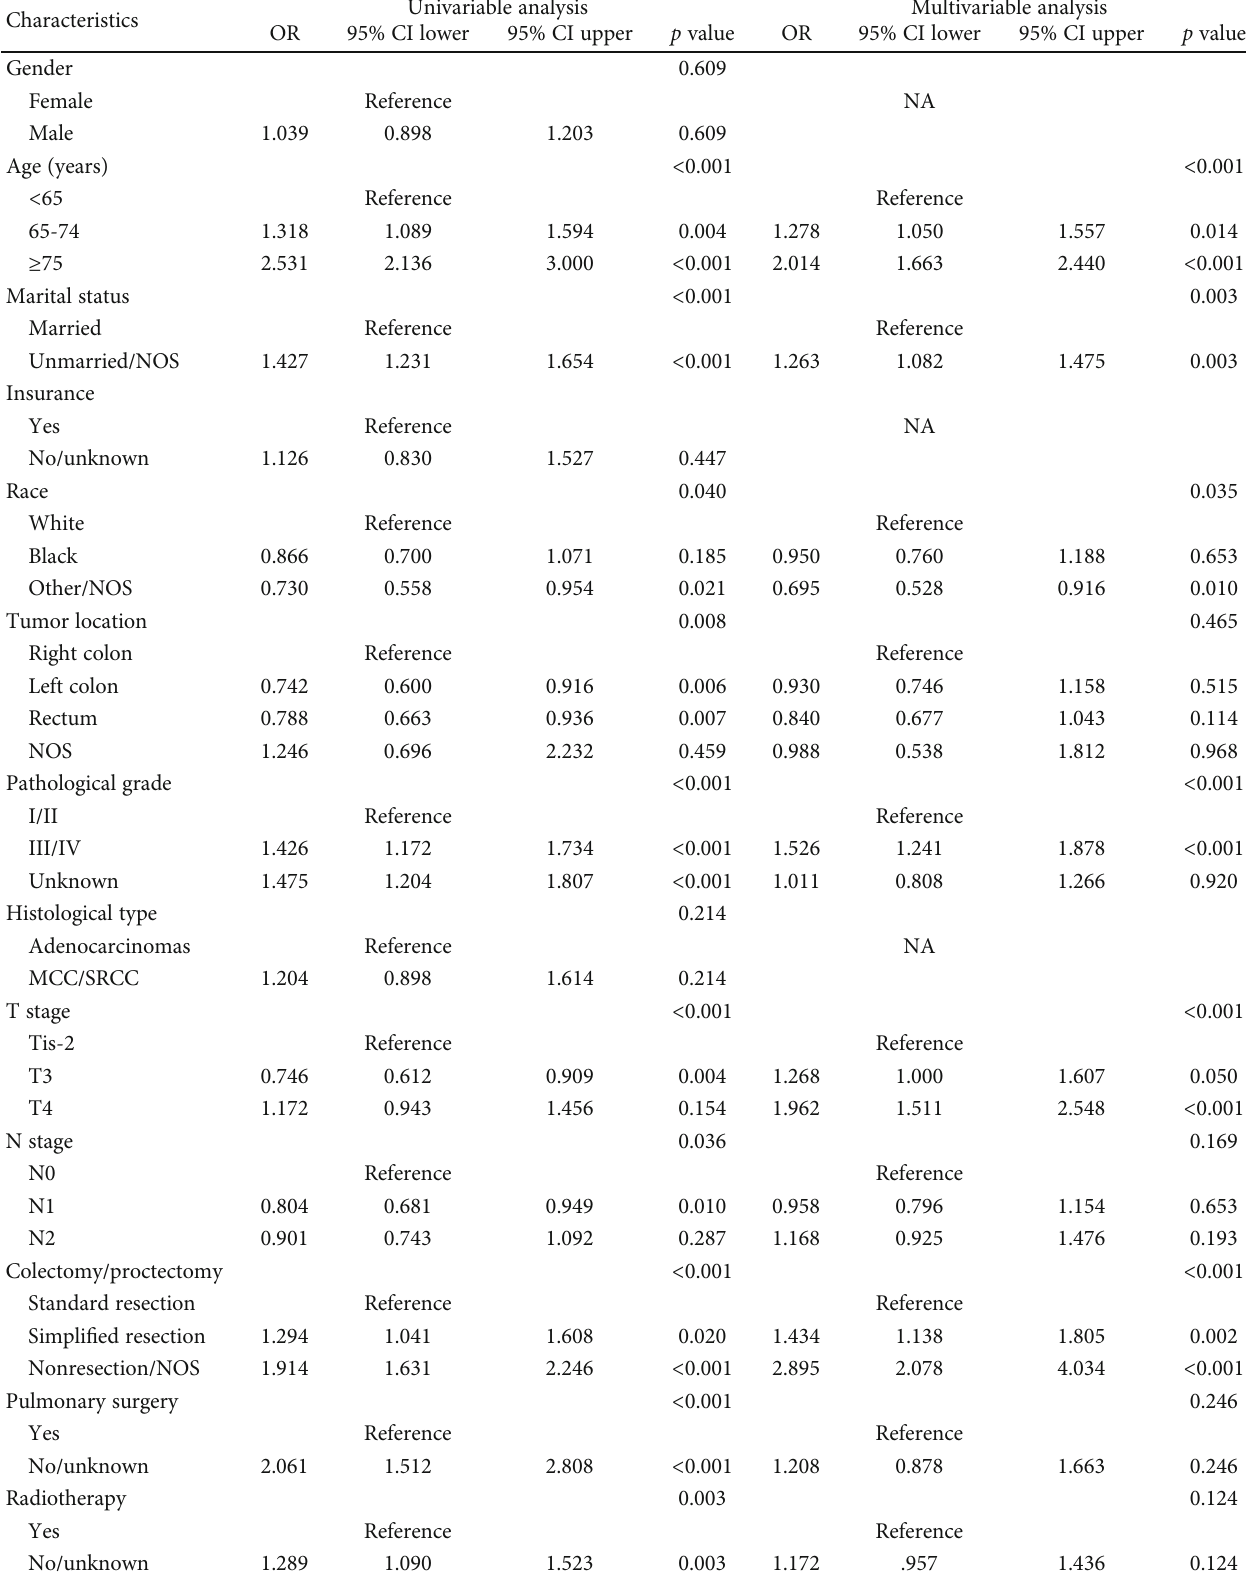
Table 3: Univariable and multivariable Cox regression